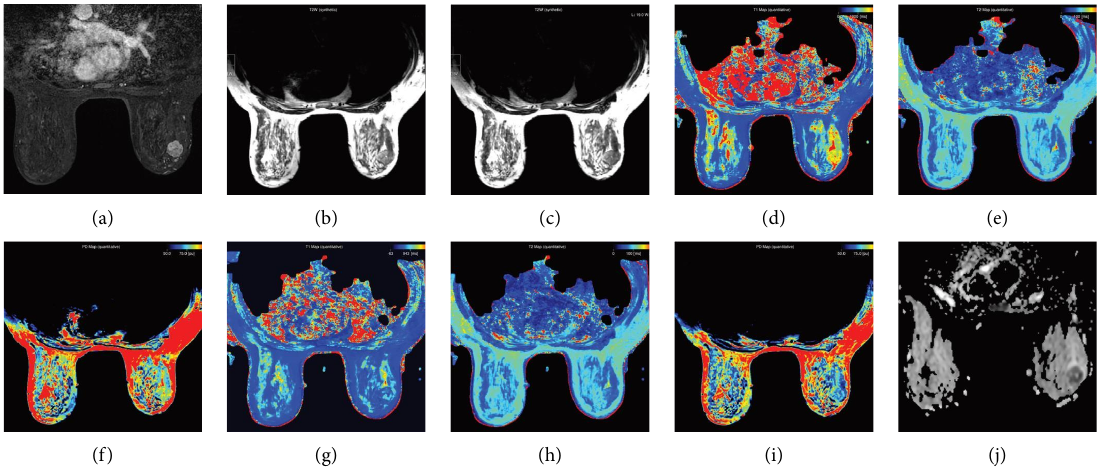
Figure 3: 51-year-old female with invasive ductal carcinoma (IDC) of the right breast. Ki-67 expression was 50%. Axial contrast enhanced T1-weighted image (T1WI) showed an irregular heterogeneous enhancing mass with irregular margin (a) Te quantitative parameters were measured on SyMRI-T2WI before ((b) pre-T1 � 1509ms, pre-T2 � 80 ms, and pre-PD � 82pu) and after ((c) post-T1 � 703ms, post- T2 � 72ms, and post-PD � 72.1pu) administration of the contrast medium. Similar images are shown for the mass on precontrast ((d) T1 mapping, (e) T2 mapping, and (f) PD mapping) and postcontrast ((g) T1 mapping (h) T2 mapping, and (i) PD mapping) enhanced mapping images. Te apparent difusion coefcient (ADC) value was 0.763 × 10 − 3 mm 2 /s on the ADC map image